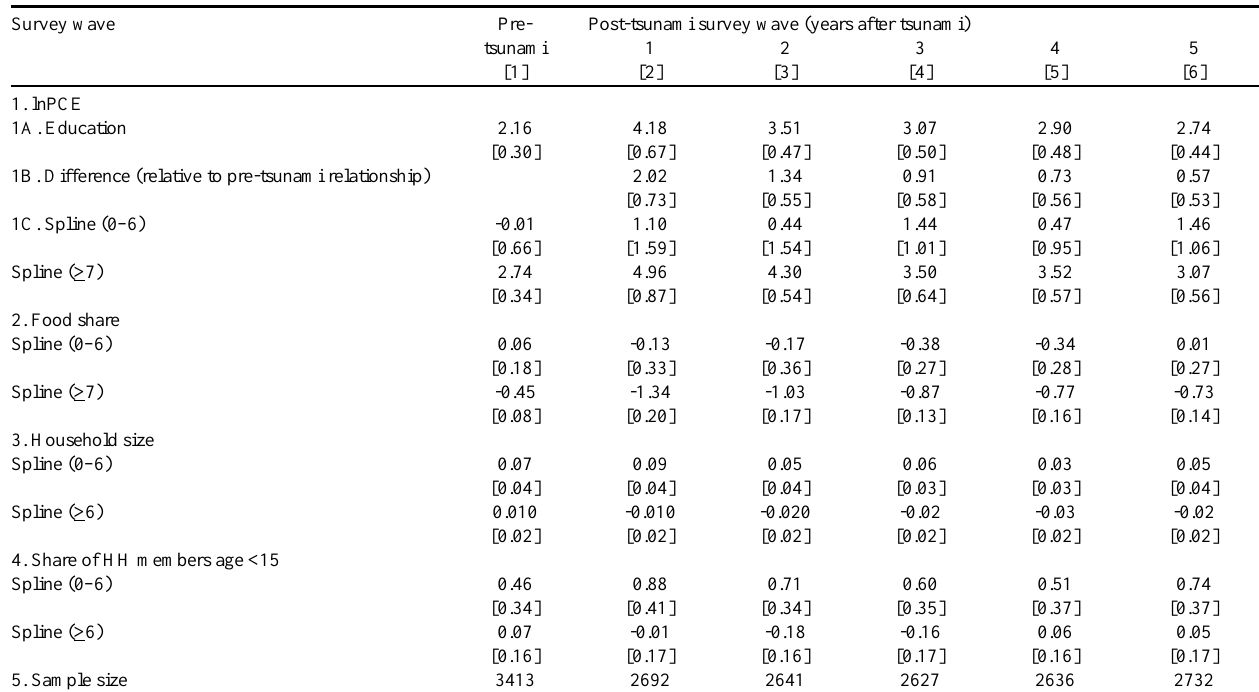
Table 5. Economic resources and household composition Survey